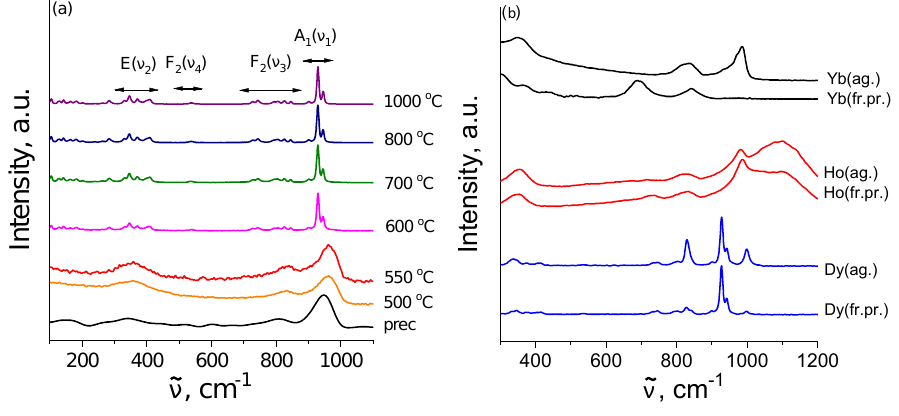
Figure 7. Raman spectra of Gd 2 (WO 4 ) 3 samples synthesized by the annealing of the precursor at different temperatures ( a ); fresh prepared and cooled in a desiccator (fr.pr.) and hydrated Dy 2 (WO 4 ) 3 , Ho 2 (WO 4 ) 3 and Yb 2 (WO 4 ) 3 well-crystallized powders aged in air 1.5 years (ag.) ( b